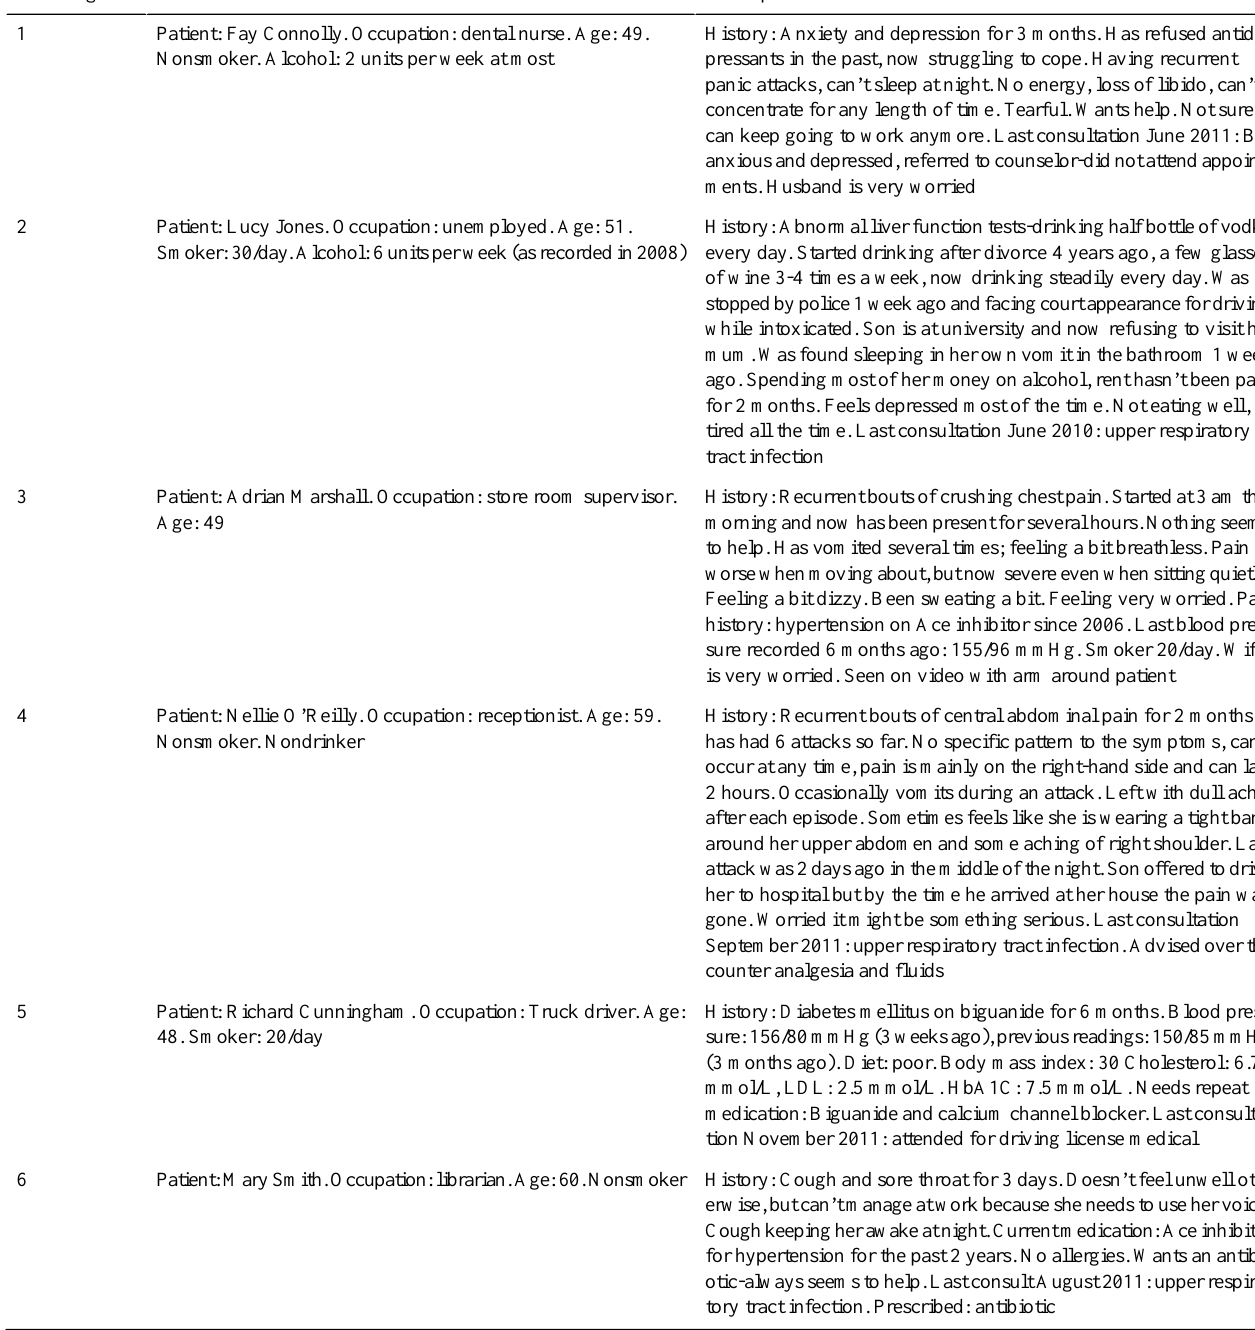
Table 1. Scenarios presented to participants in videos.